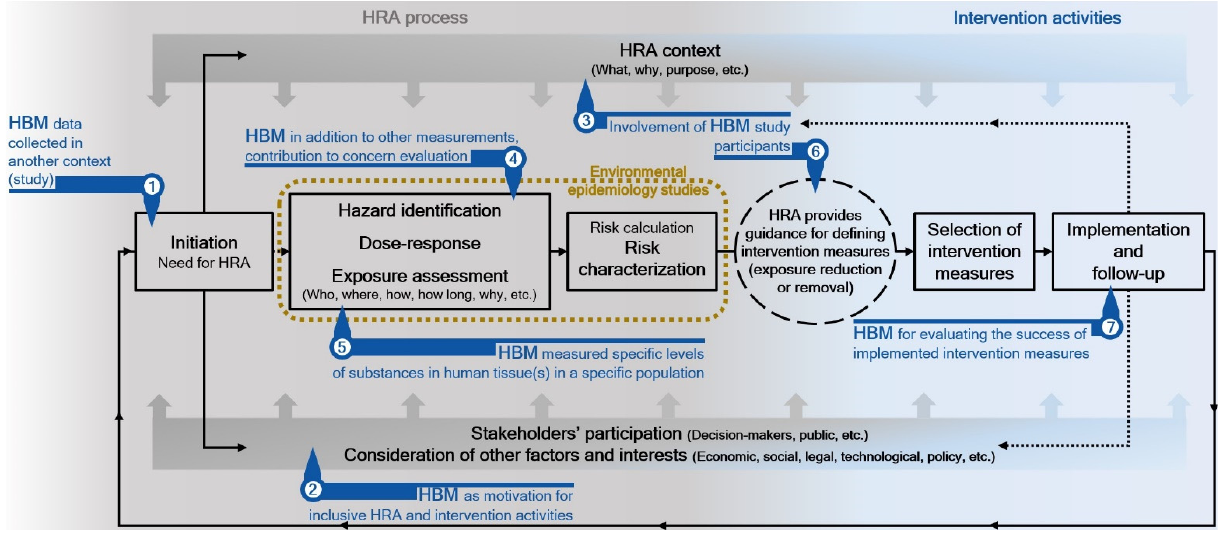
Figure 3. Potential uses of human biomonitoring in the health risk assessment context.